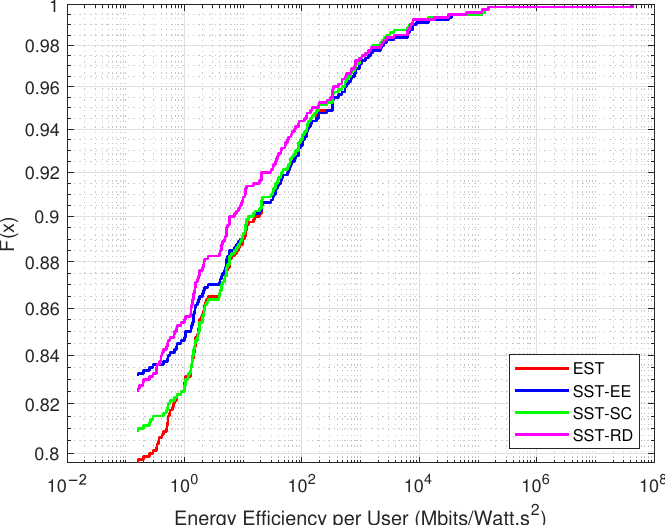
Figure 7. Variation in the distribution of the energy efficiency in the JSS.